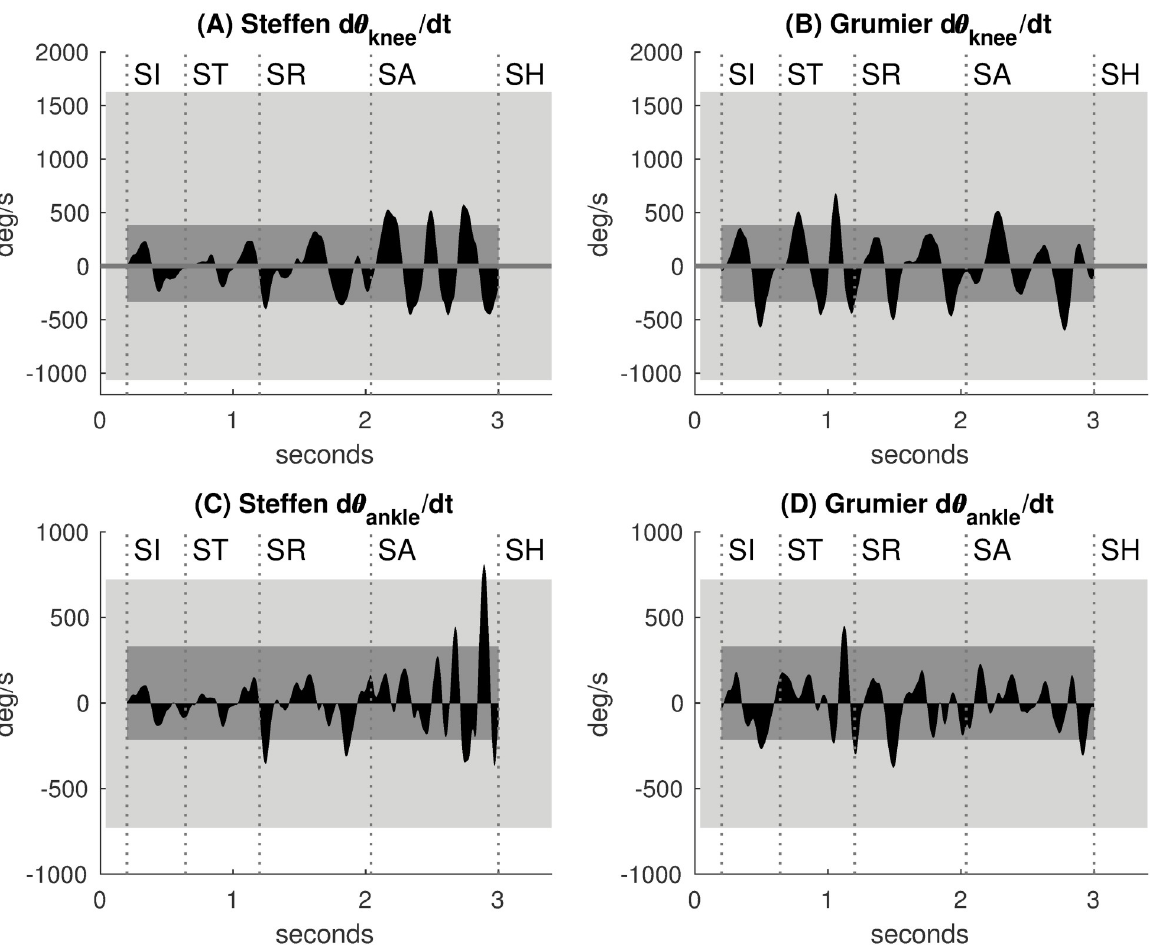
Fig 16. Knee and ankle angular velocities. Light rectangles: MaxAV , maximum angular velocities for sport from Jessop et al. [16]. Dark rectangles: WalkingAV , angular velocities during walking from Mentiplay et al. [15]. (A,B,C,D) The knee and ankle angular velocities of Steffen and Grumier are mainly within WalkingAV and enhanced during their offensive